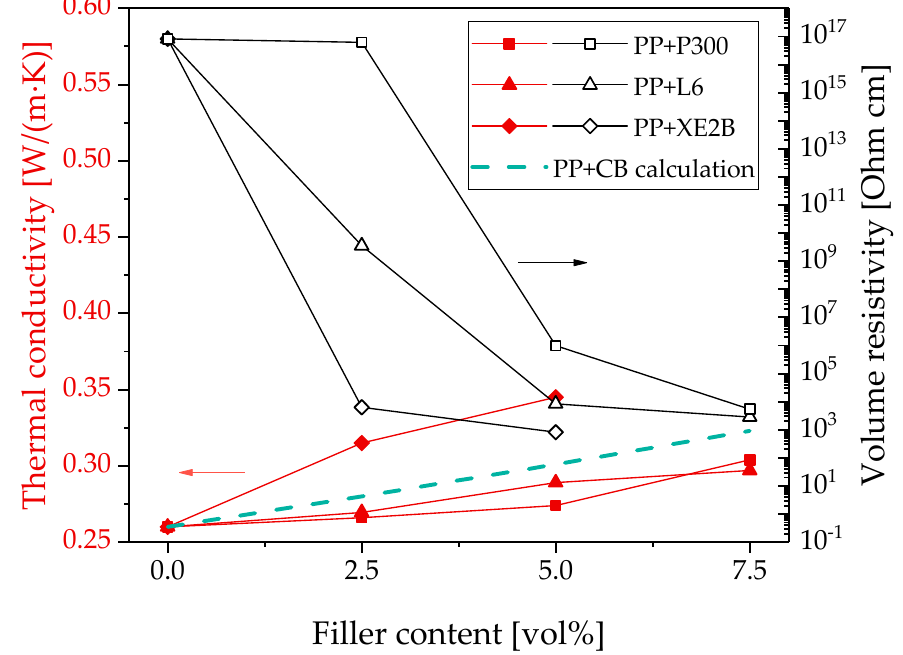
Figure 1. Thermal conductivity and electrical volume resistivity of polypropylene (PP) filled with different kinds of carbon black; values calculated using the Hatta model [48].